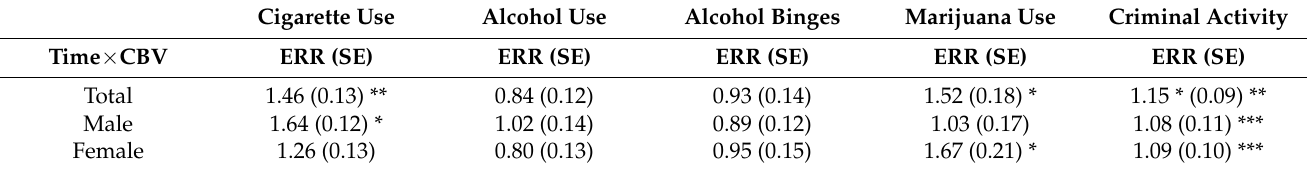
Table 5. Changes of the parameter estimates in substance use and criminal activity over time by